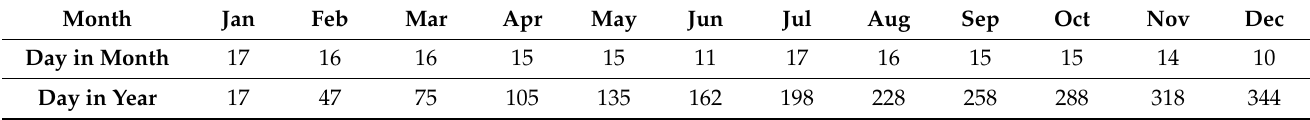
Table 4. Data of the respective days for each